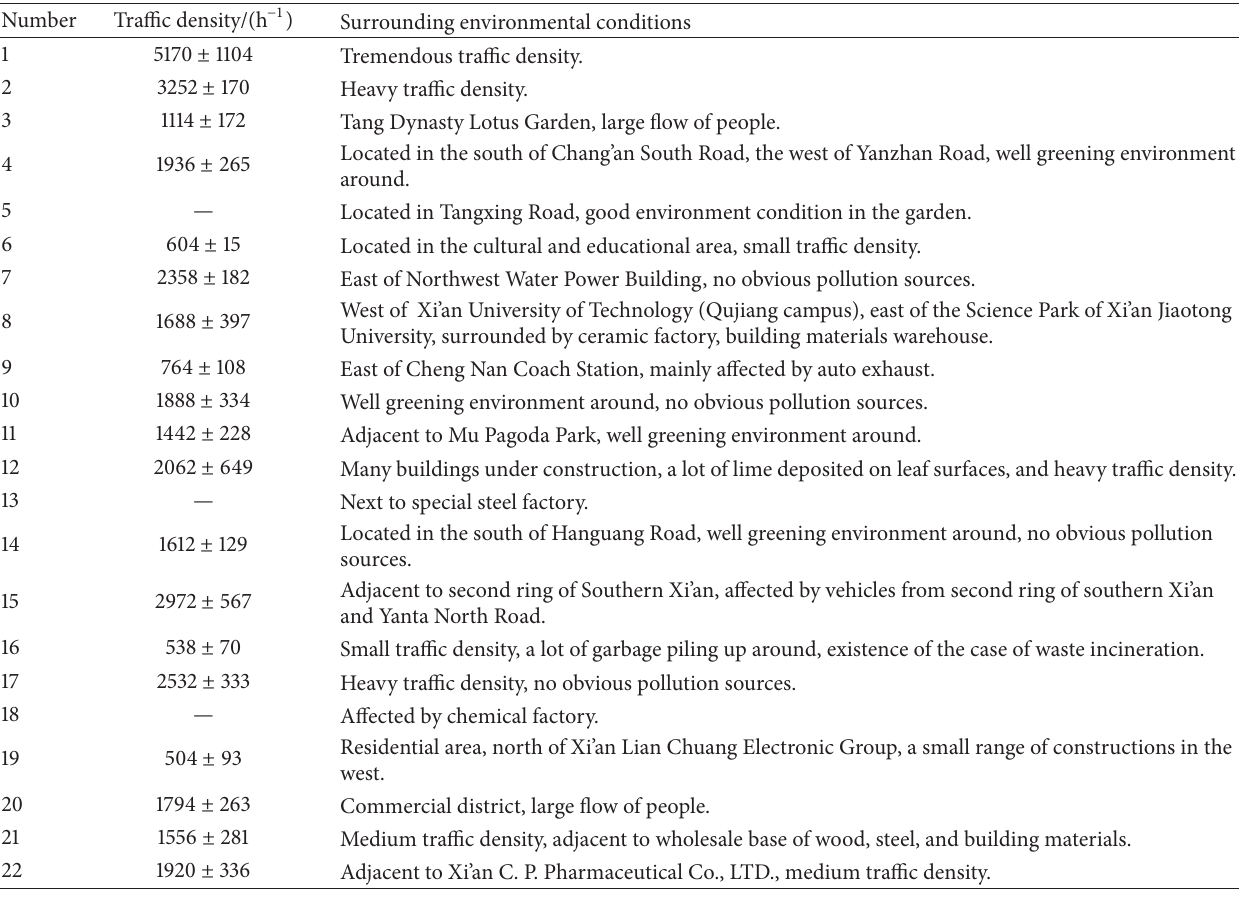
Table 1: The measured traffic density and environmental conditions in areas around sampling sites (— indicates not measured).